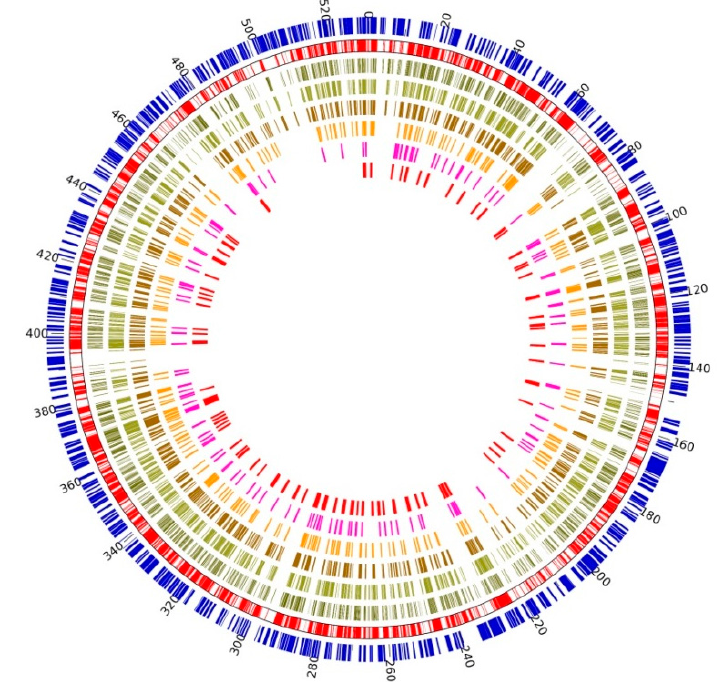
Figure 2. Self-repetition in the mitochondrial genome of M. crassipes. From the inner circle to the outer circle, the six histograms in the inner circle showed the position and length of repetitive sequences with different lengths (red histograms, repeat sequence length > 800 bp; lavender histograms, repeat sequence length between 600–800 bp; orange histograms, repeat sequence length between 400–600 bp; dark brown histograms, repeat sequence length between 200–400 bp; light brown histograms, repeat sequence length between 100–200 bp; light gray histograms, repeat sequence length less than 100 bp); the outer second red circle showed the position information overlapping all repetitive sequences; and the outer blue bars showed the position information of genes without considering the direction.